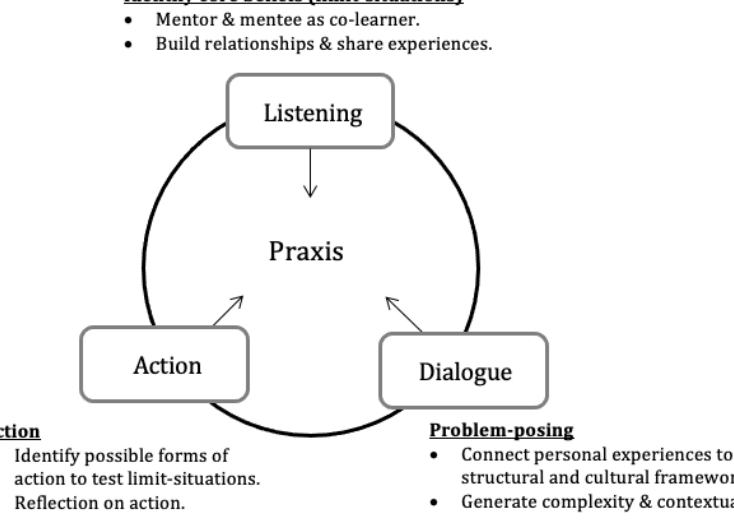
FIGURE 1: CRITICAL PEDAGOGY FOR UNDERGRADUATE PEER